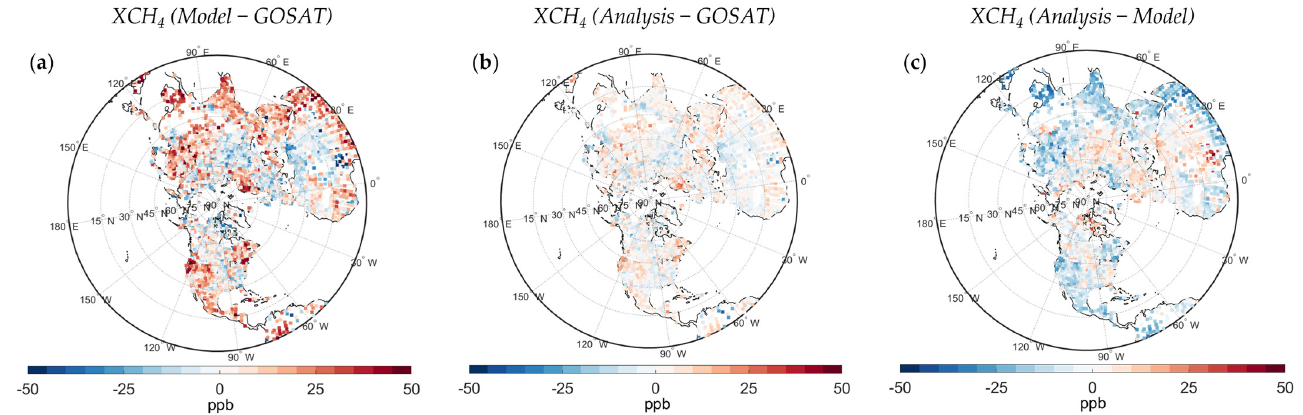
Figure 10. Differences between ( a ) model and GOSAT, ( b ) analysis and GOSAT, and ( c ) analysis and model in the observation space in April 2010.